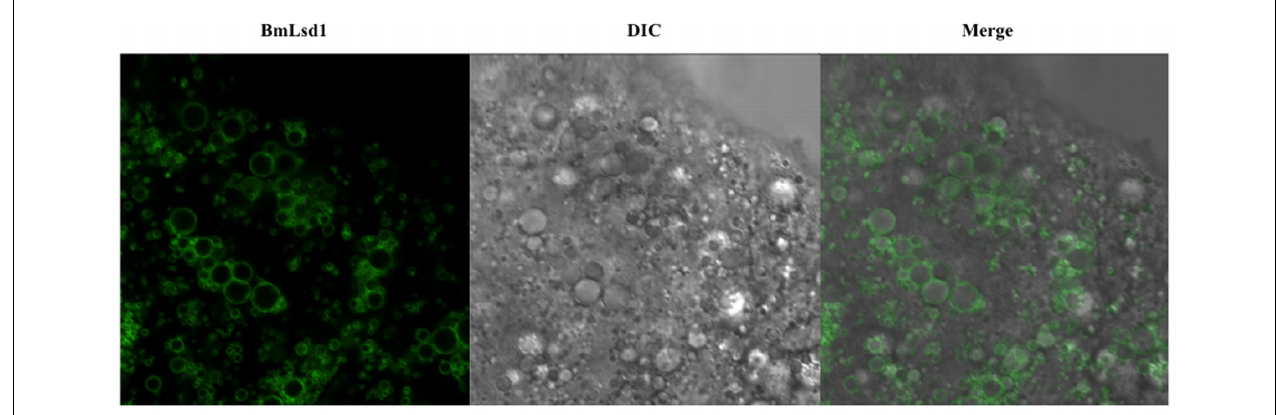
FIGURE 5 | Localization of BmLsd1 in the pheromone-producing cells of B. mori . Following dissection and trimming of the PG, pheromone-producing cells were analyzed by confocal microscopy. EGFP-BmLsd1 fluorescence image (BmLsd1), differential interference contrast image (DIC), and the merged image (merge) are